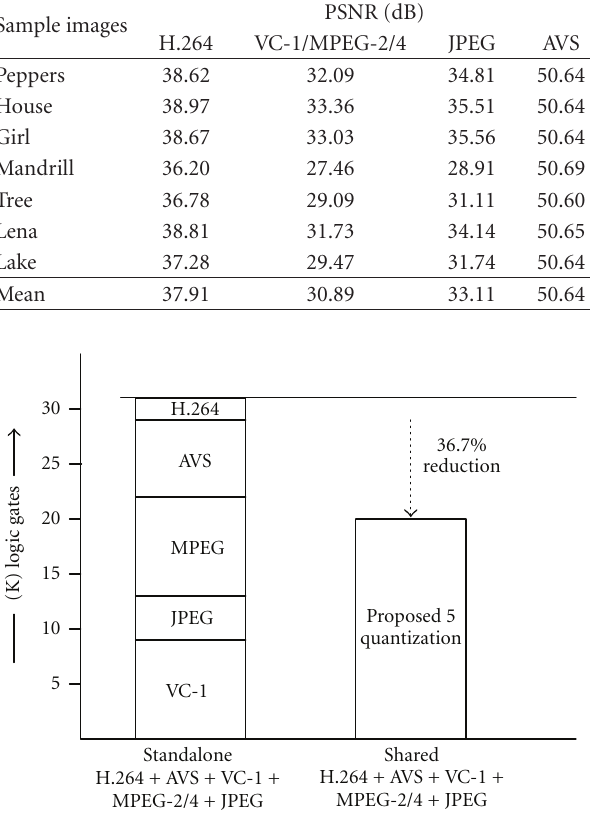
Figure 6: Comparison in terms gate